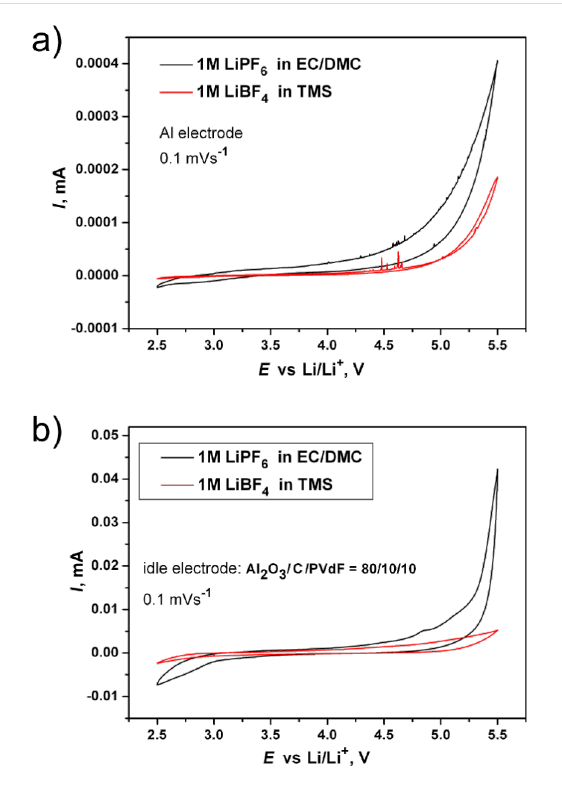
Figure 2: Cyclovoltammetry curves (first cycle) of 1 M LiPF 6 in EC/ DMC (black) and 1 M LiBF 4 in TMS (red) at scan rate of 0.1 mV·s − 1 . (a) Aluminum electrode, (b) idle electrode consisting of Al 2 O 3 /C/PVdF in an 80/10/10 ratio. Investigation of Li (Co,M)PO F (M = Mn, Fe) 2 4